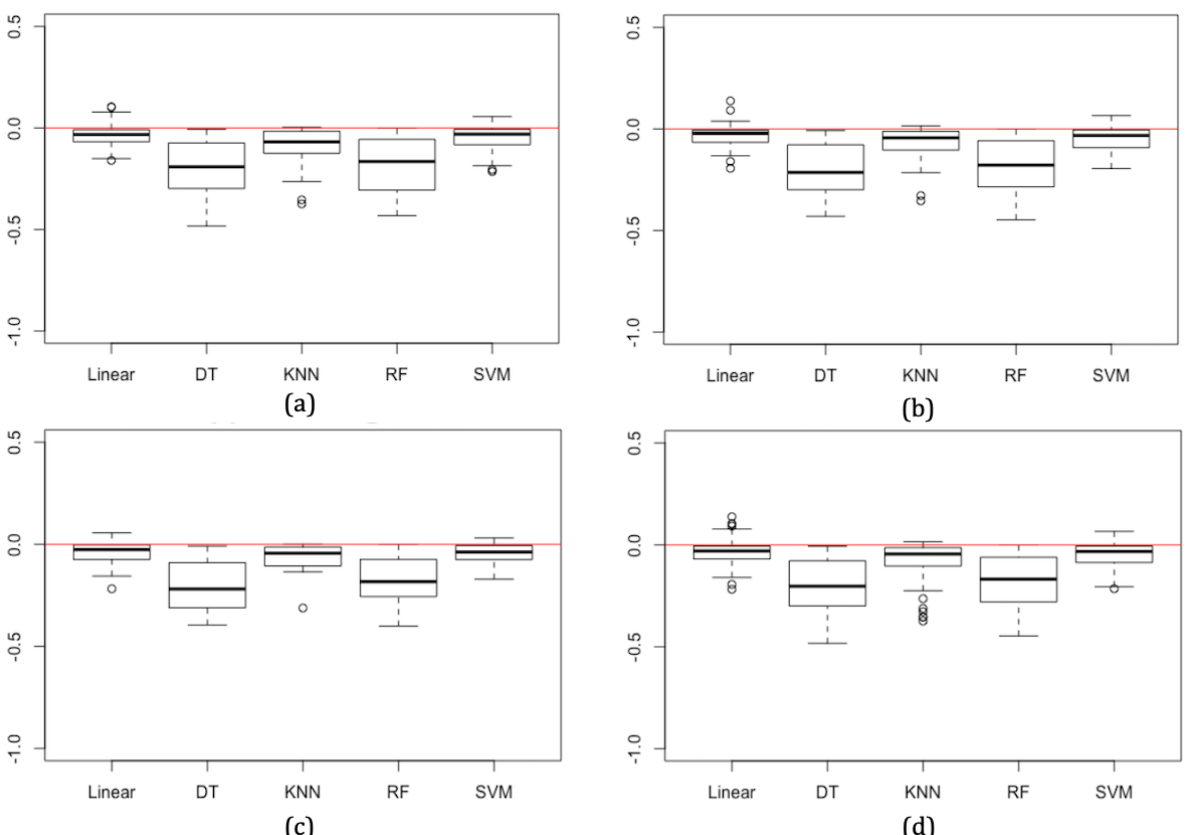
Figure 5. Overall change in accuracy for each machine learning model when trained on synthetic data across 19 datasets and 2 synthetic data approaches (classification and regression tree [CART] and parametric) and with statistical disclosure control measures applied where smoothing (a; numeric attributes only), unique removal (b), minimum leaf size constrained (c; for CART synthesizer only), and all approaches combined (d), compared with models trained using real